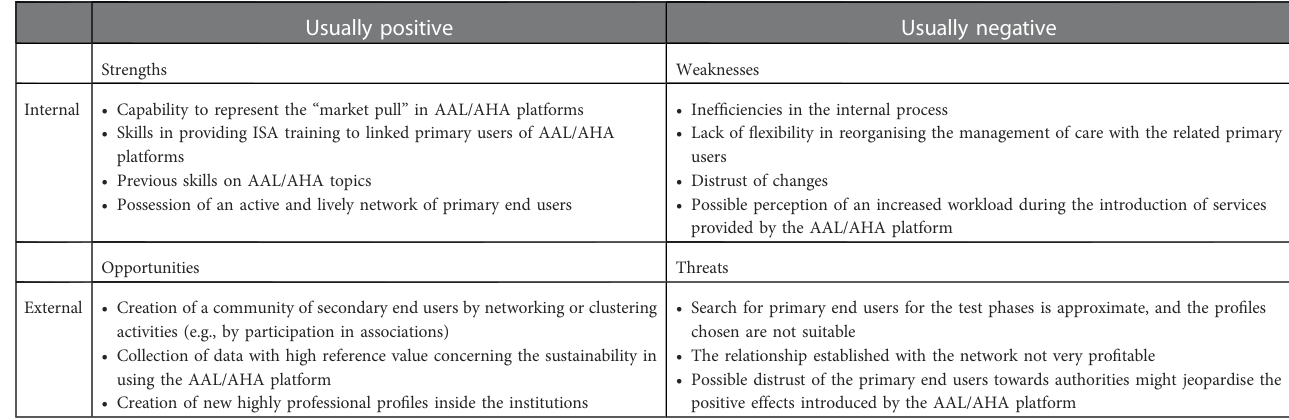
TABLE 3 SWOT for secondary end users, together with authorities and facilitators.